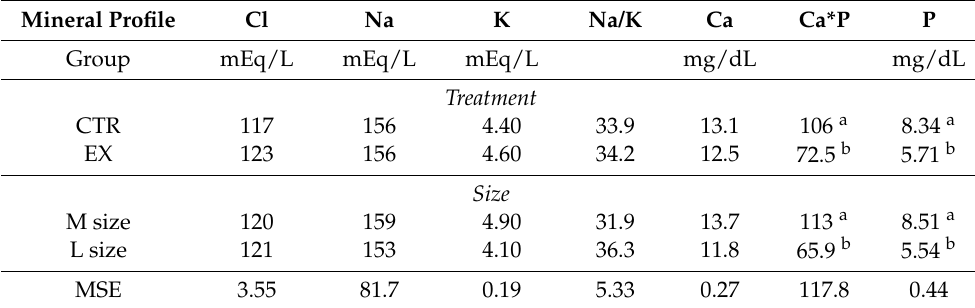
Table 6. Effect of treatment and size on bitches’ mineral profile during the